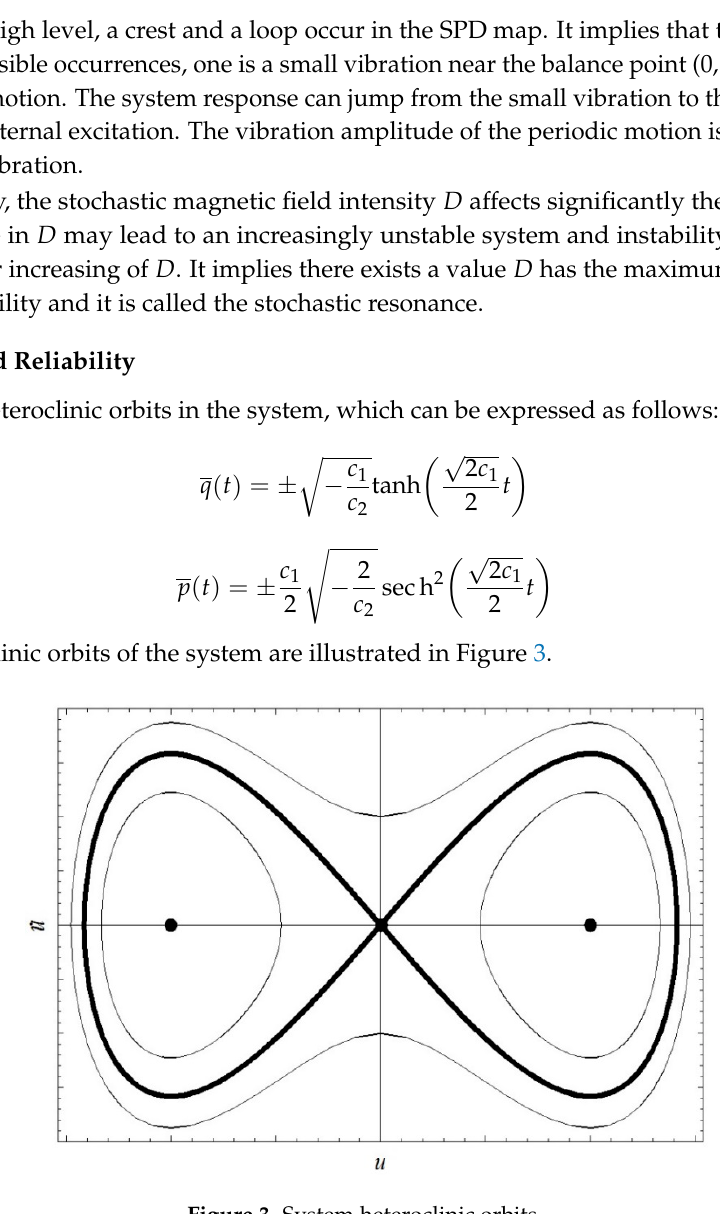
Figure 3. System heteroclinic orbits.